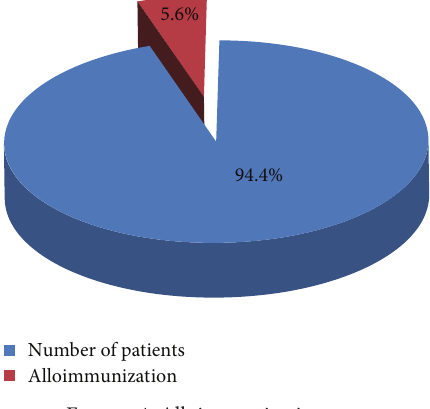
Figure 4: Alloimmunization